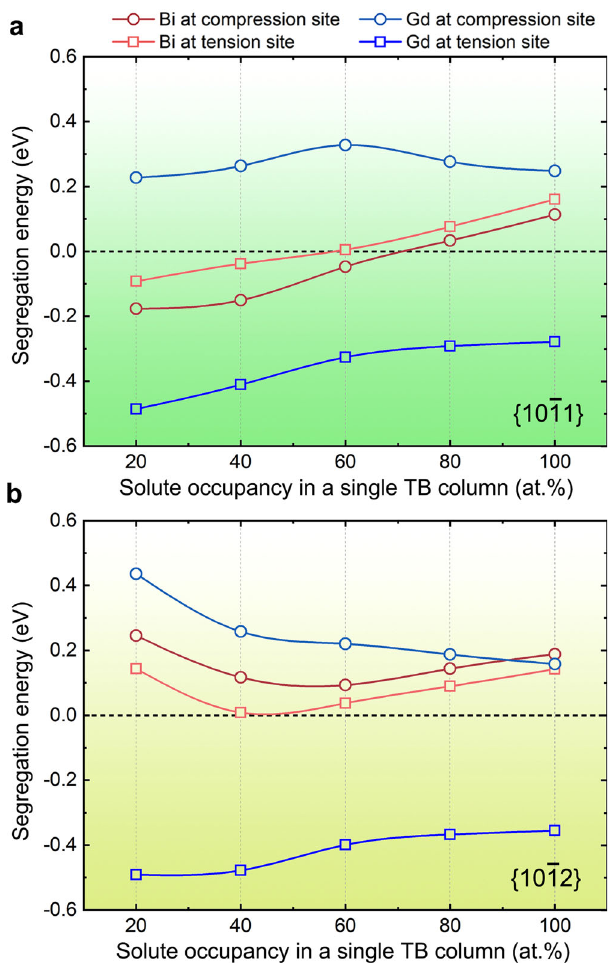
Fig. 3 First-principles calculations of segregation energy. Calculated solute segregation energies with different solute occupancies in a single atom column of a {1011} and b {1012} CTBs.